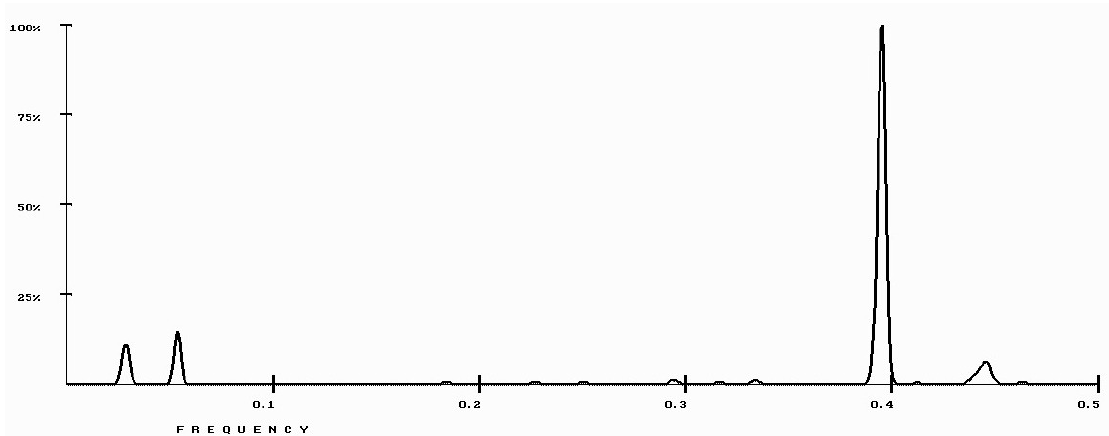
Figure 6. RRM cross-spectrum of stromal cell-derived factor-1 (SDF-1 α ) proteins. The prominent common characteristic frequency for these proteins is at f3 = 0.3975 ± 0.0108, which represents an electromagnetic radiation wavelength of about 502 nm.